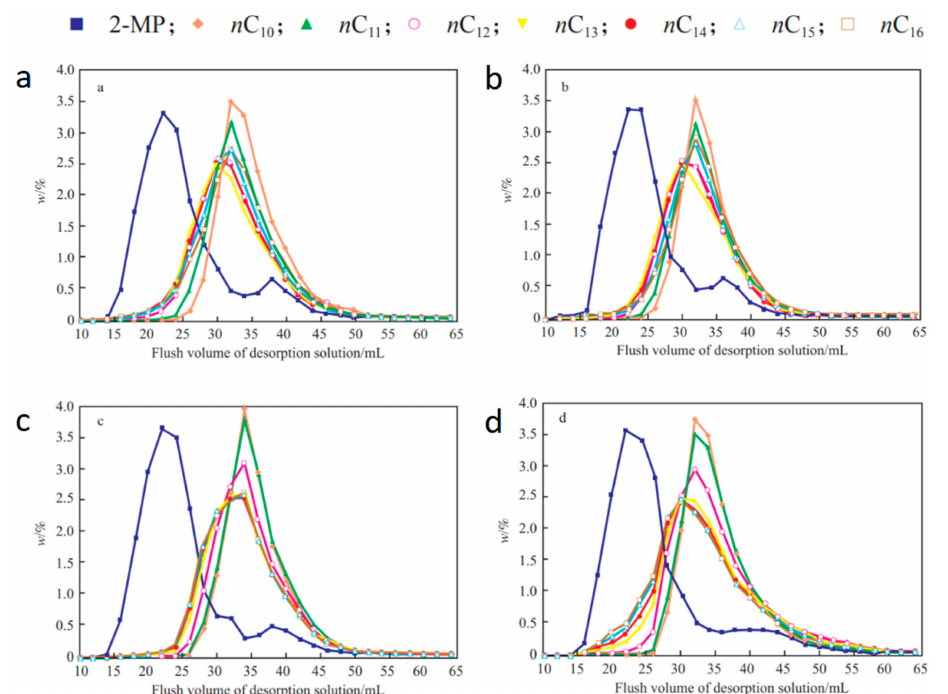
Figure 8. Pulse spectra of adsorbent Ca 2+ exchange degree [36] ( a ) 70.8% ( b ) 85.5% ( c ) 91.9% ( d )